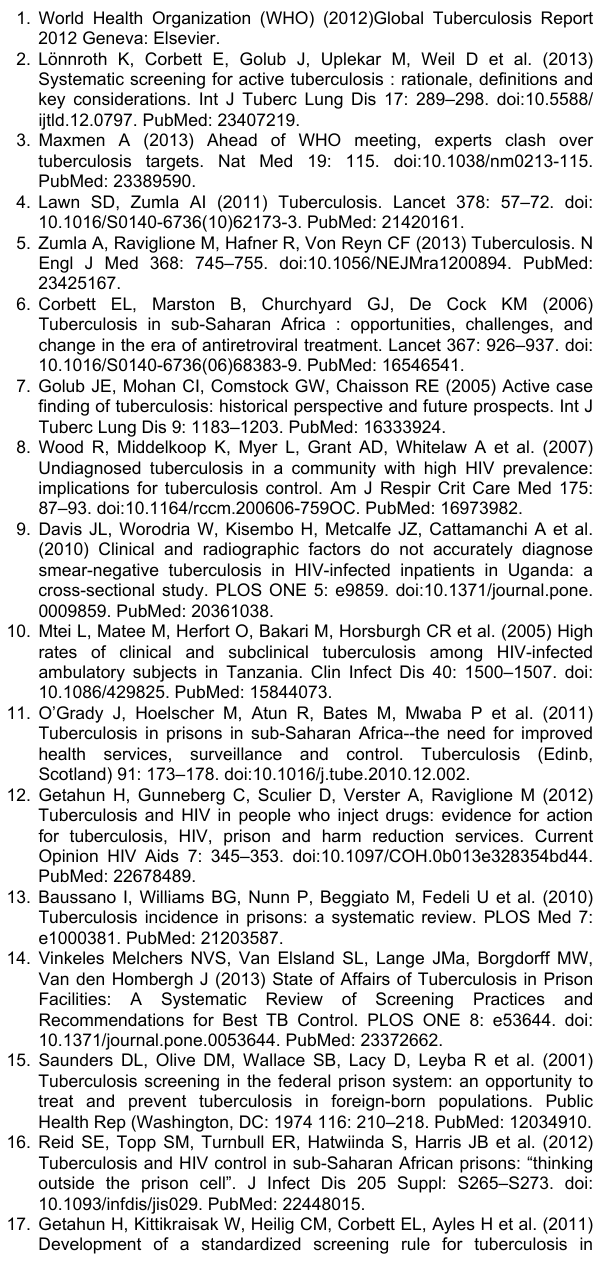
Table S1. Correlates of Undiagnosed Active Pulmonary